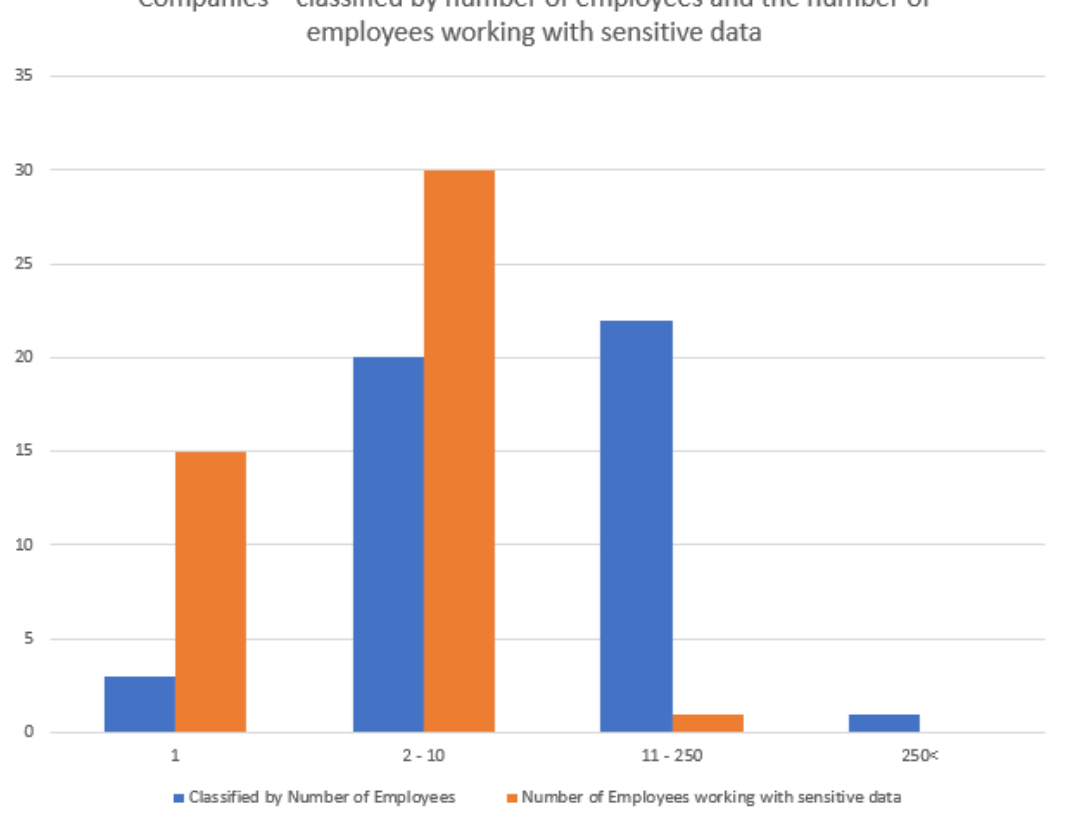
Figure 6. Number of employees at the examined